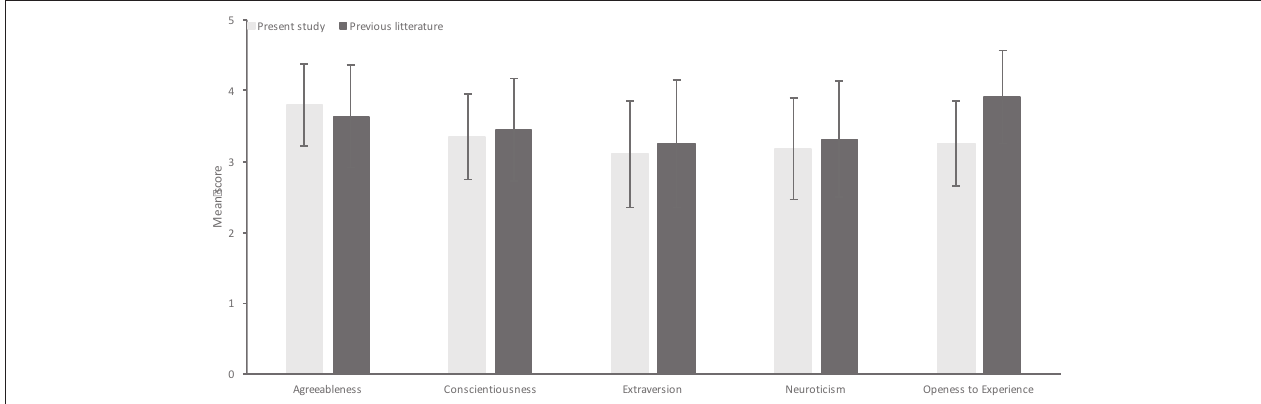
FIGURE 2 | Means and SDs from the present study for each BFI variable including means and SDs obtained for the same variables in previous research. Means from the previous literature are based on results reported by Srivastava et al. (2003), where data from age group 20 was used, as in Study 1.